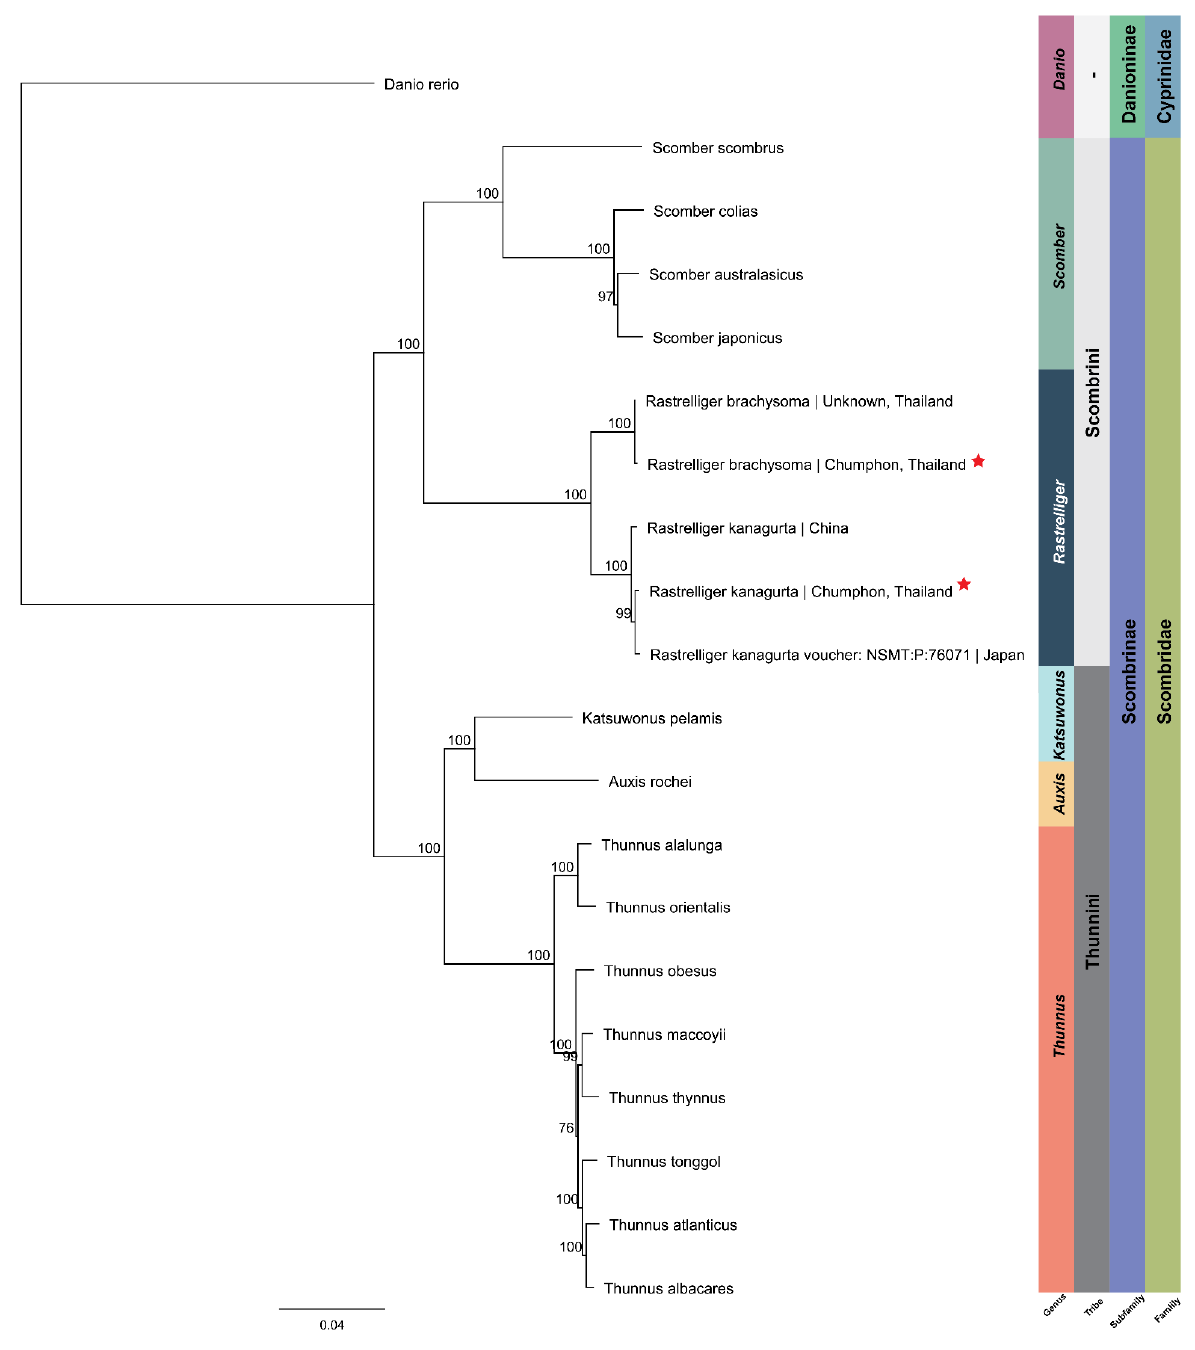
Figure 6. The phylogenetic tree was constructed from mitochondrial genomes of 20 species from the family Scombridae using zebrafish as an outgroup. The red star represents the species used in this study. this